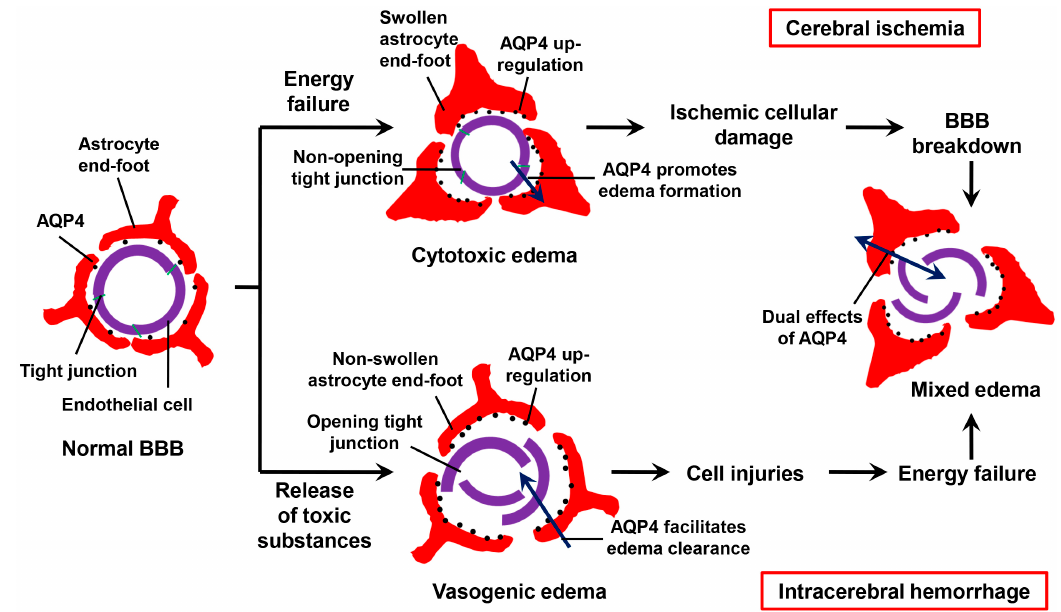
Figure 2. Mechanisms of edema formation and the effects of AQP4 in cerebral ischemia and intracerebral hemorrhage (ICH). In cerebral ischemia, AQP4 promotes water entry into perivascular astrocyte end-feet resulting in cytotoxic edema. As further ischemic cellular damage evolves, the mechanism shifts into vasogenic edema. During ICH, release of multiple toxic substancescauses disruption of blood–brain barrier (BBB), which gives rise to vasogenic edema. AQP4 facilitates the reabsorption of edema fluid from the extracellular space. Then secondary cellular injury leads to energy failure causing cytotoxic edema. Thus, mixed brain edema exists in the two types of stroke but the predominant type is different [17,58,69,70].